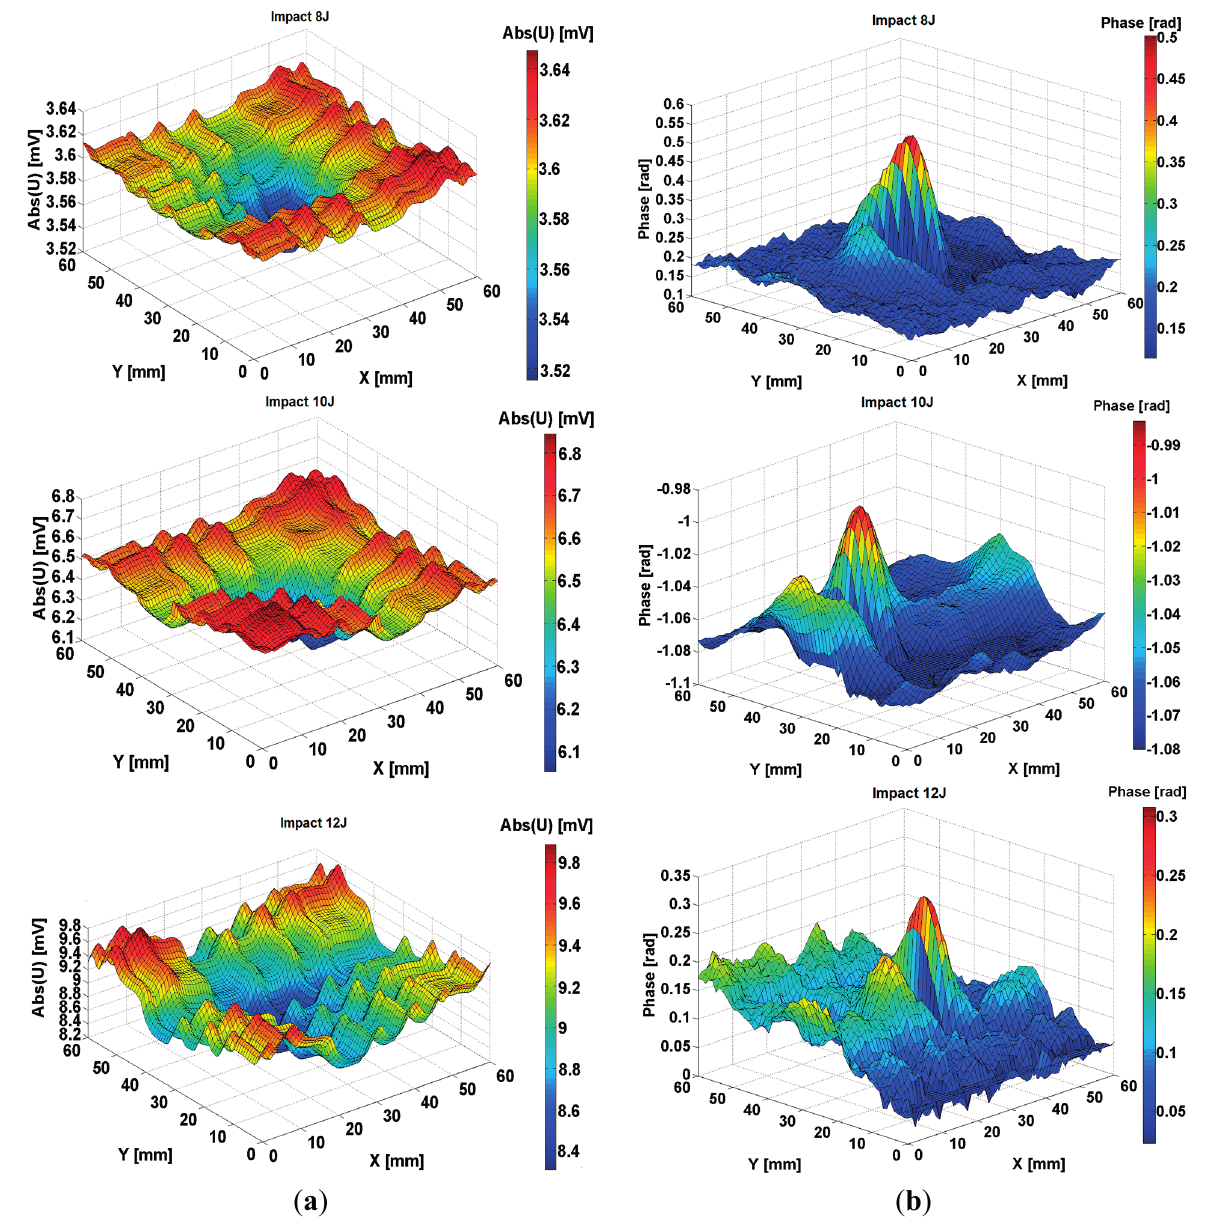
Figure 10. The measured signal delivered by the electromagnetic sensors with MM lens at scanning of composite FRPC quasi-isoptropic in plane samples impacted with 8 J, 10 J and 12 J energy ( a ) amplitude; ( b )